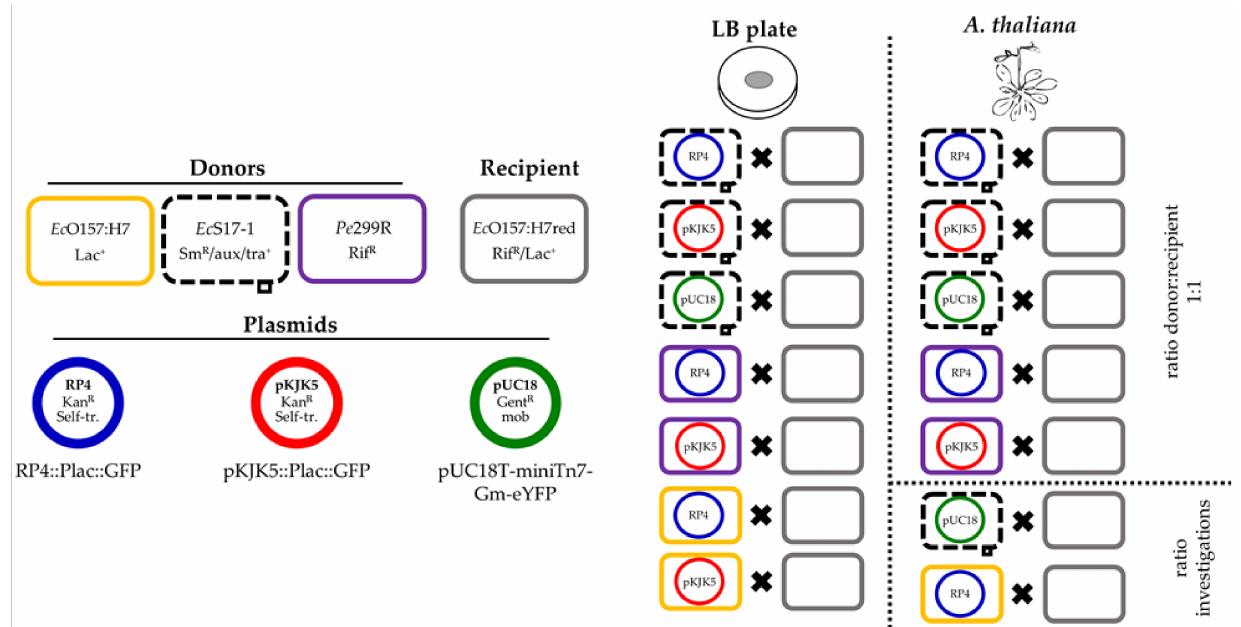
Figure 1. Overview of performed experiments. Three donors, Ec O157:H7, Ec S17-1, and Pe 299R, were combined with up to three different plasmids, RP4, pKJK5, or pUC18. The ability of the hosts to transfer the plasmids to the recip- ient Ec O157:H7red was assessed on membrane filters and gnotobiotic A. thaliana . Additionally, the effect of different donor/recipient ratios onto conjugation frequency was assessed for two exemplary donor and plasmid